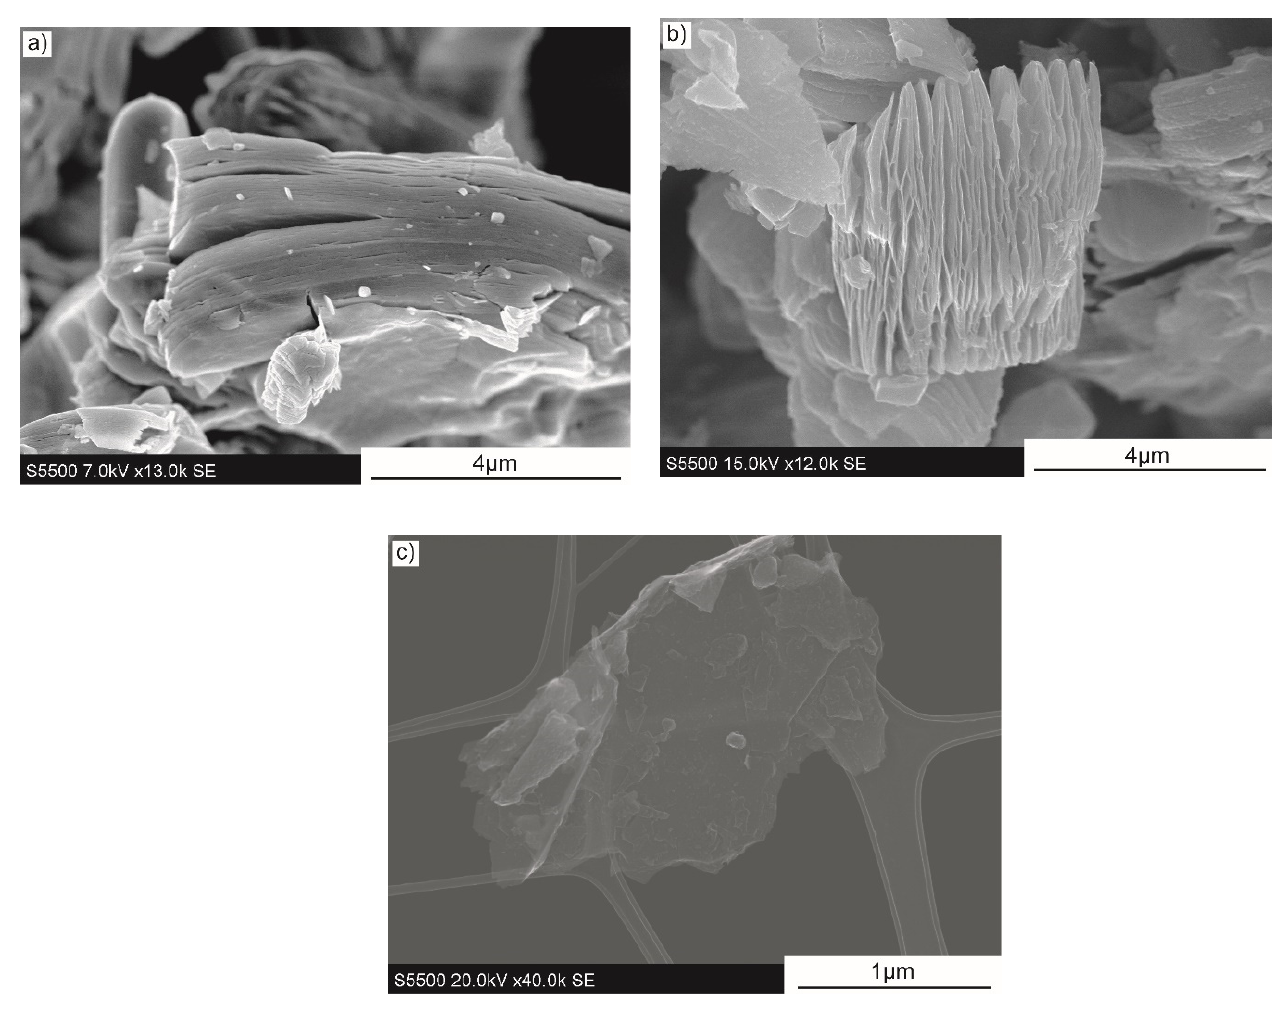
Figure 1. The morphology of ( a ) synthesised Ti 3 AlC 2 , ( b ) etched MAX phase, ( c ) Ti 3 C 2 MXene. final MXene phase was performed. The obtained diffraction patterns are presented